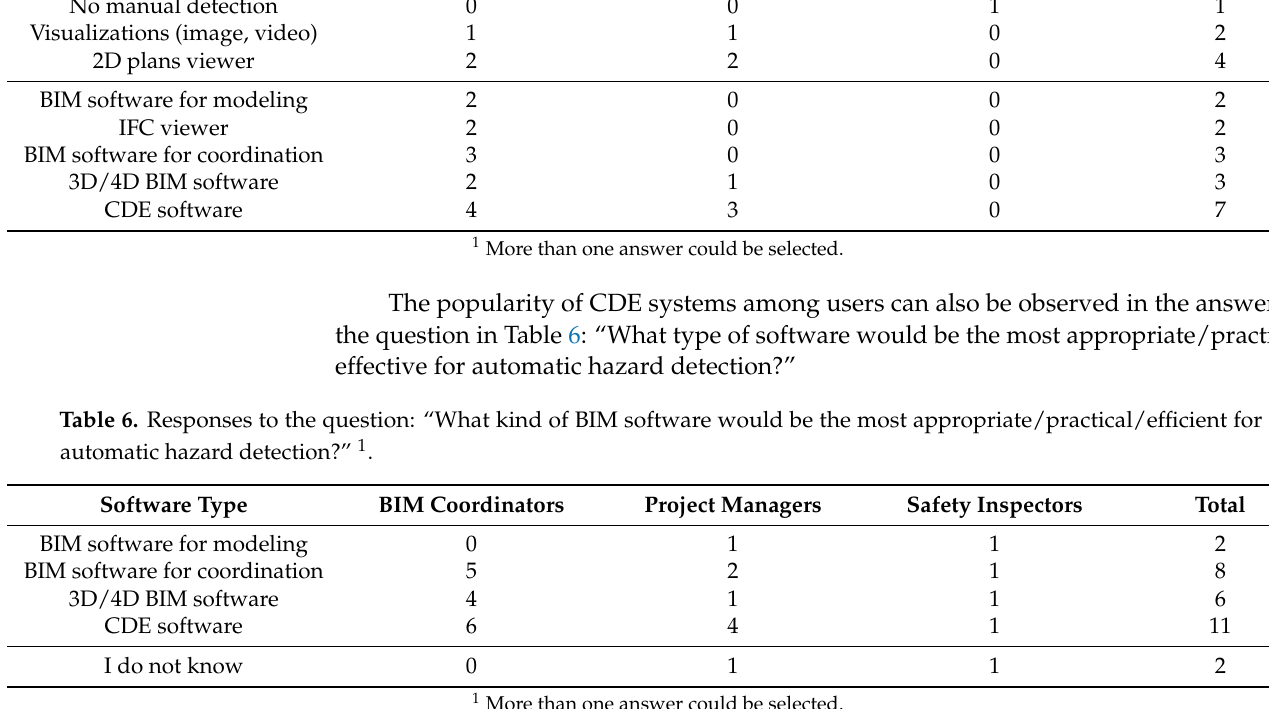
Table 5. Responses to the question: “What kind of software do you currently use for manual hazard detection?” 1 . Software Type